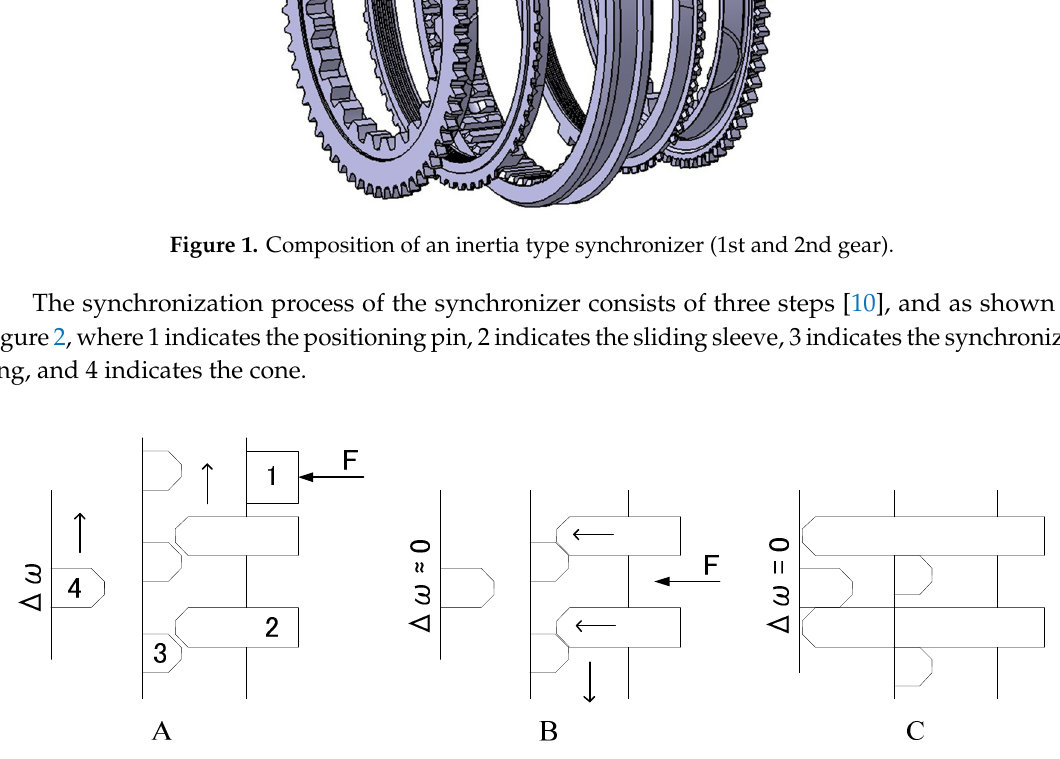
Figure 1. Composition of an inertia type synchronizer (1st and 2nd gear).